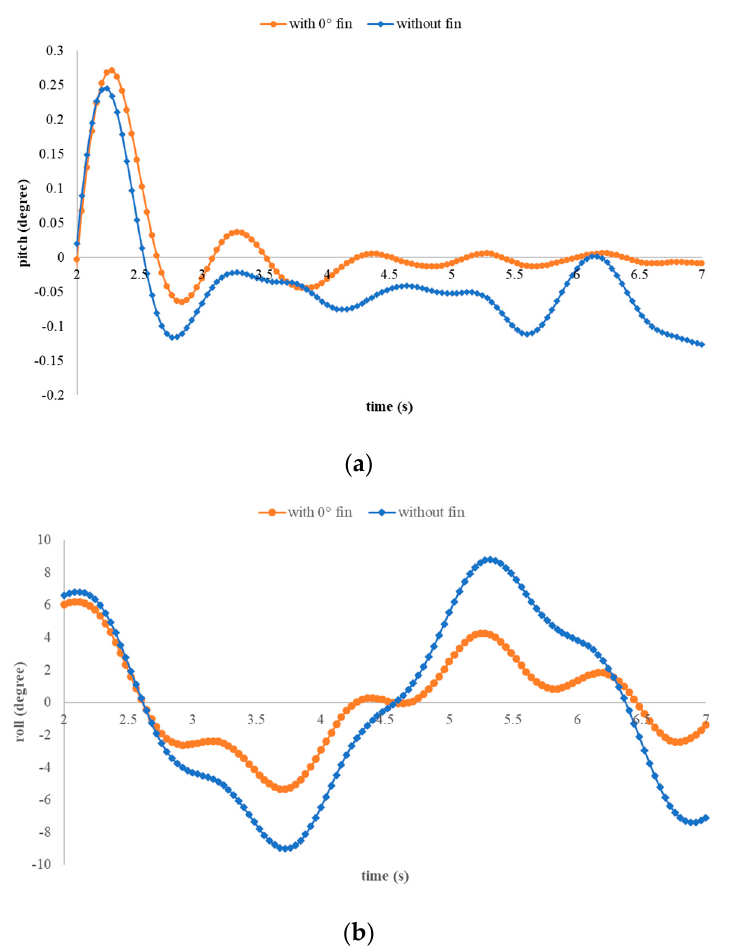
Figure 20. The pitch and roll motion comparison W/O fin at 22 kn speed. ( a ) Pitch motion. ( b ) Roll motion.